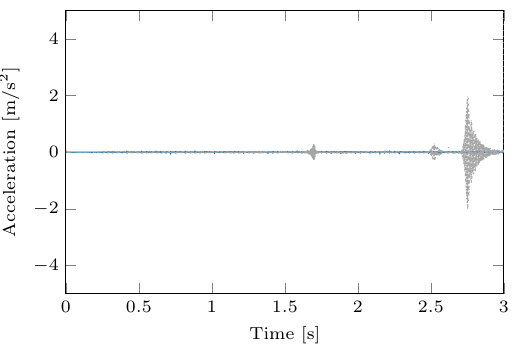
Figure 5. Vertical acceleration of point T : comparison between Subs-a and FiLm method.